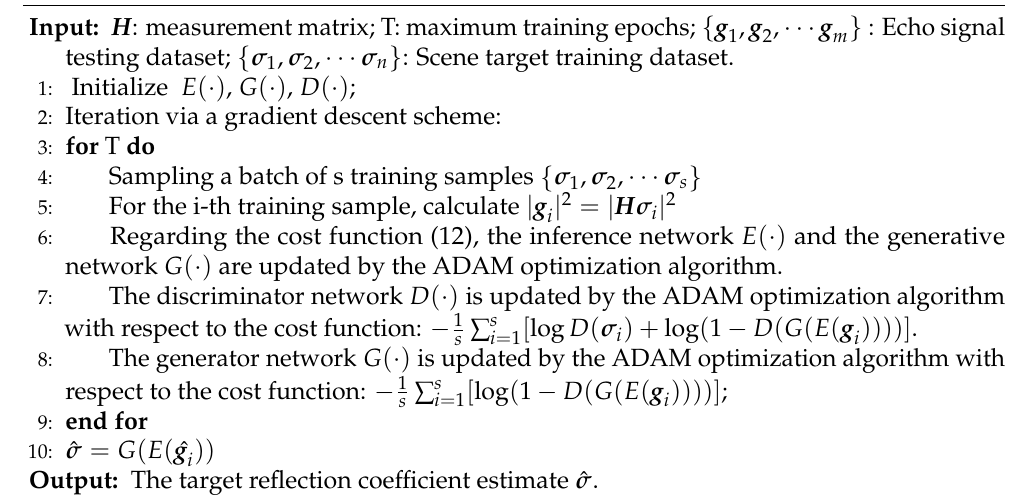
Algorithm 1 PFDI-Net training